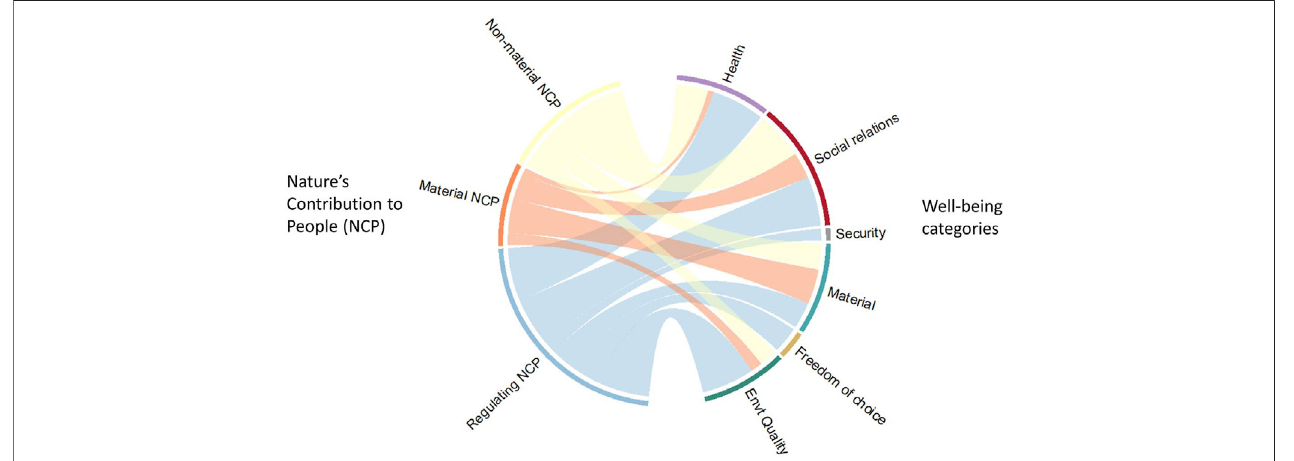
FIGURE3| IllustrativediagramshowingrelativecontributionofNCPtothesixbroadwell-beingcategories.Theseresultsareillustrativeastheyarebasedonasmall sample size of government agency employees and are not intended to be representative of New Zealand population. The width of the chords is representative of the number of NCP-well-being relationships that scored high in the prioritization process. See Table 4 for exact numbers.